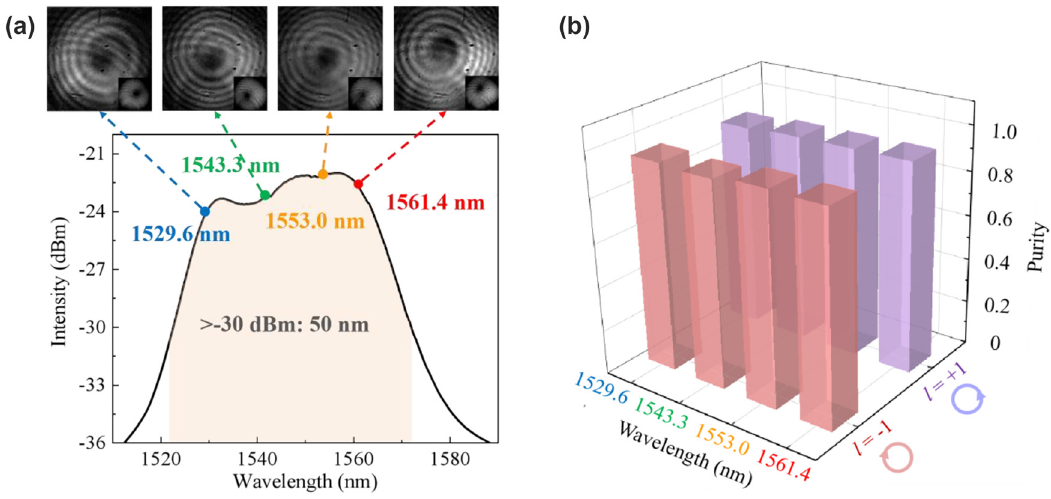
Figure 8: Fluorescence characteristics of the OAM-based light source. (a) OAM fluorescence spectrum. The tops are the mode patterns and spiral-shaped interferograms of the first-order OAM modes. (b) The first-order OAM modes purity at 1529.6, 1543.3, 1553.0, and 1561.4 nm with topological charge l = − 1 and +